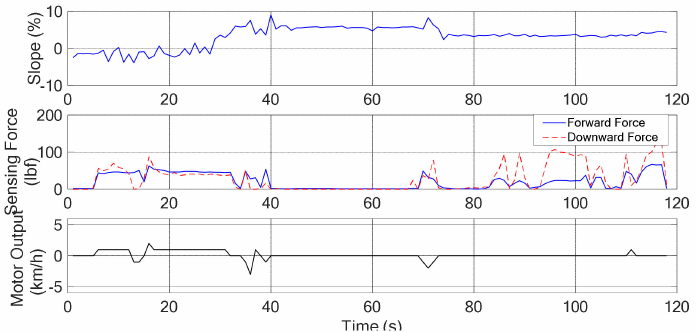
Figure 14. The degree of slope, sensing force, and the assistive motor output (flat surface).